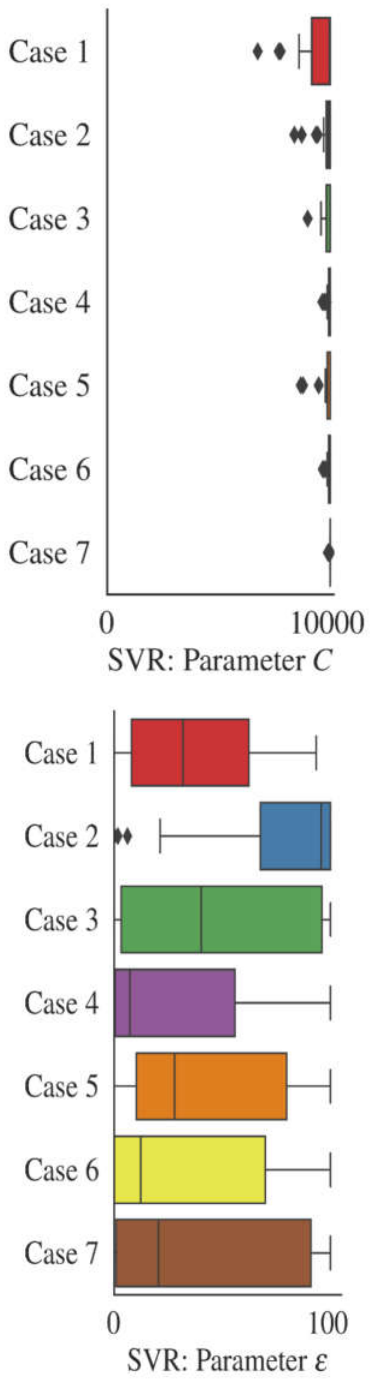
Figure 4. Distribution of the internal parameters for the SVR models over 50 independent runs. Each color represents a case study in Table 2. Black diamond shapes represent outliers.